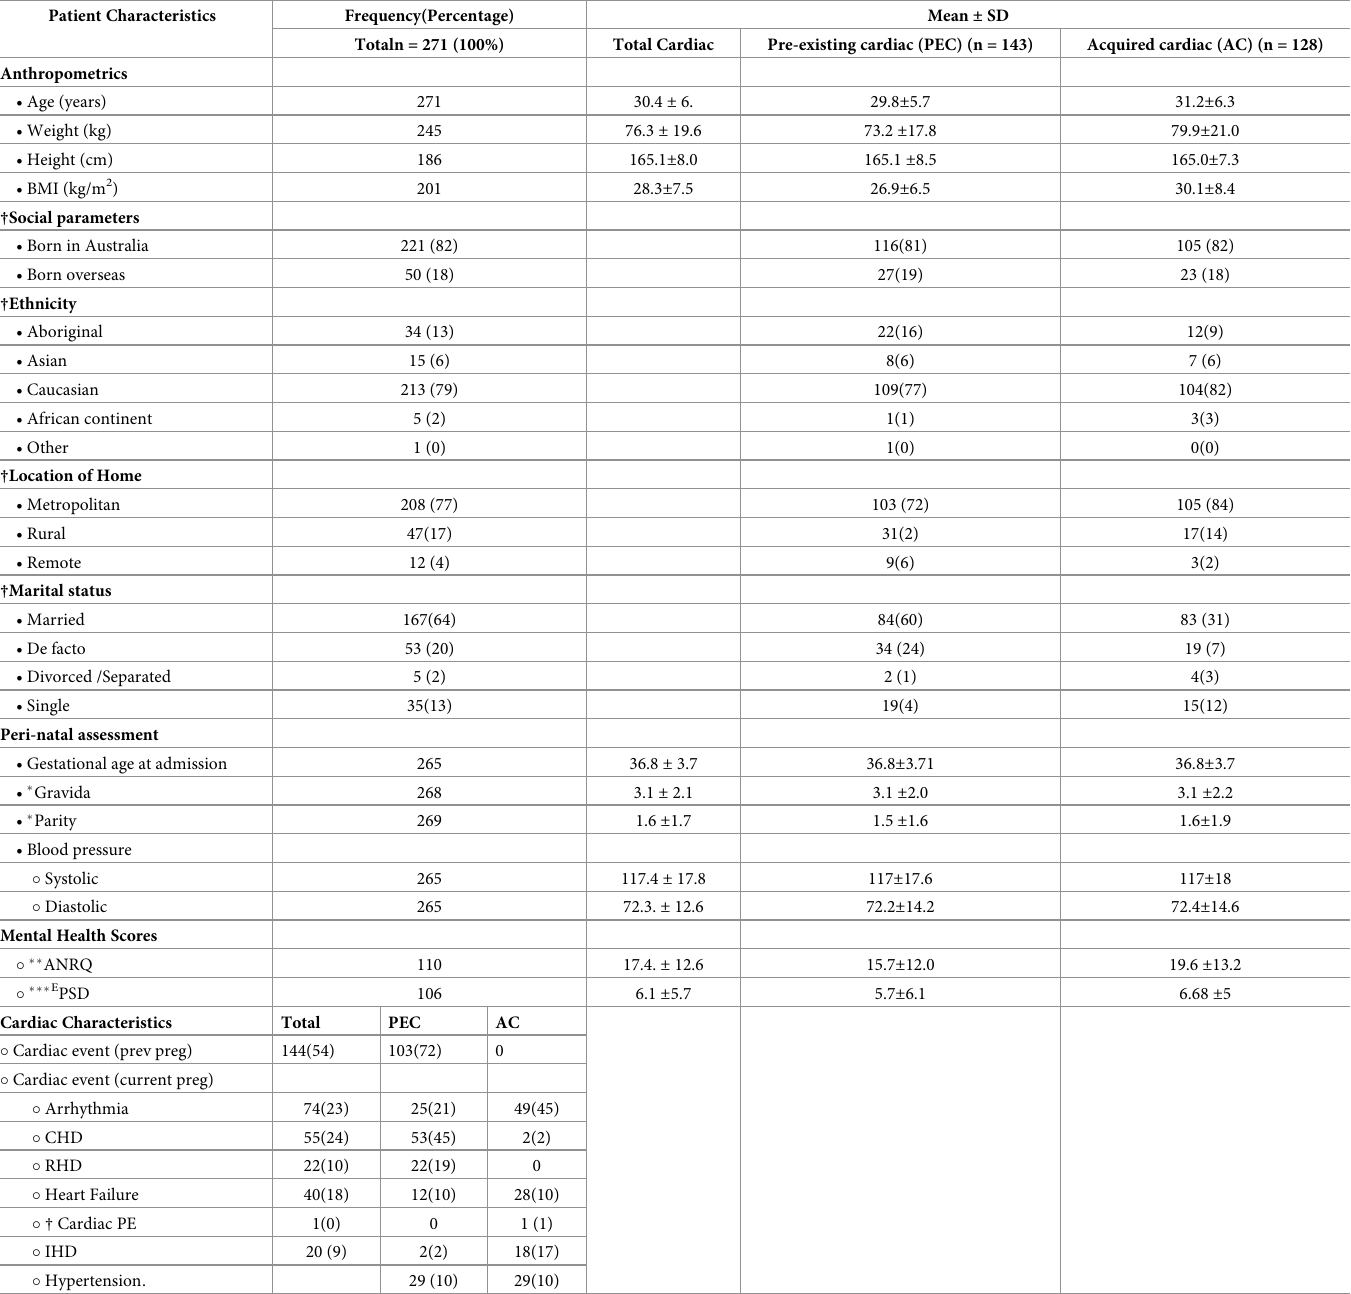
Table 1. Maternal characteristics of women with cardiac disease during pregnancy SA hospitals